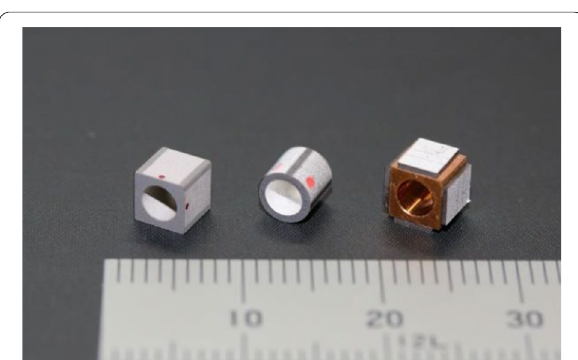
Fig. 3 Prototype stators. From the left, the cubic piezoelectric bulk stator, the cylindrical piezoelectric bulk stator, and the conventional stator comprising of a bronze cube and the thin piezoelectric plates bonded to the